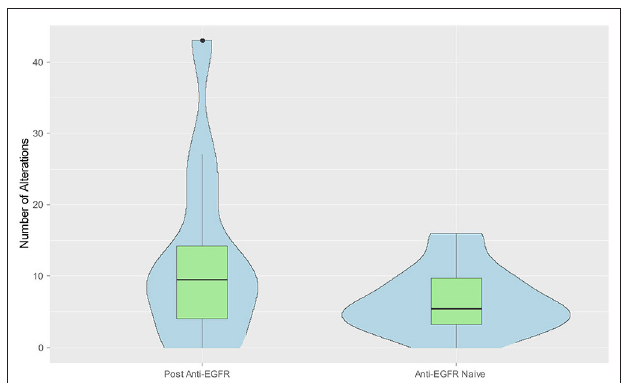
FIGURE 4 | Combined violin and box plot graph demonstrating increased number of alts in liquid biopsy post anti-EGFR therapy. Data from the blood sample collected at time of disease progression was selected when multiple measurements were available from the same patient. Median number of alts were higher post anti-EGFR ( n = 12) vs. anti-EGFR naïve liquid biopsy ( n = 22) (9.5 vs. 5.5, p =